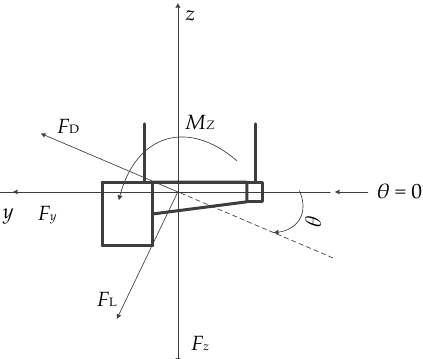
Figure 4. Definition of sectional model wind attack angle.